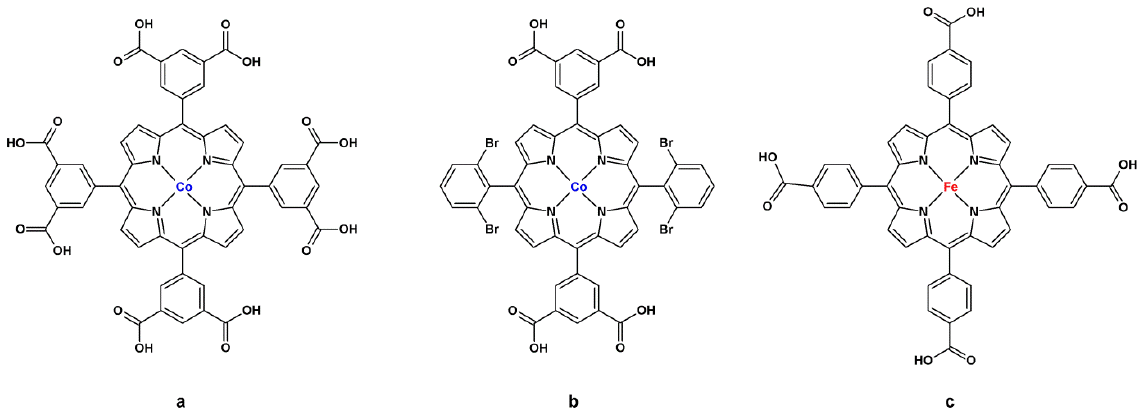
Figure 8. Building blocks of the catalytically active MMPF series. ( a ) MMPF-2 and MMPF-5 : [(tetra(3,5-dicarboxyphenyl)porphyrinate) Co(III)]; ( b ) MMPF-3 : [5,15-bis(3,5-